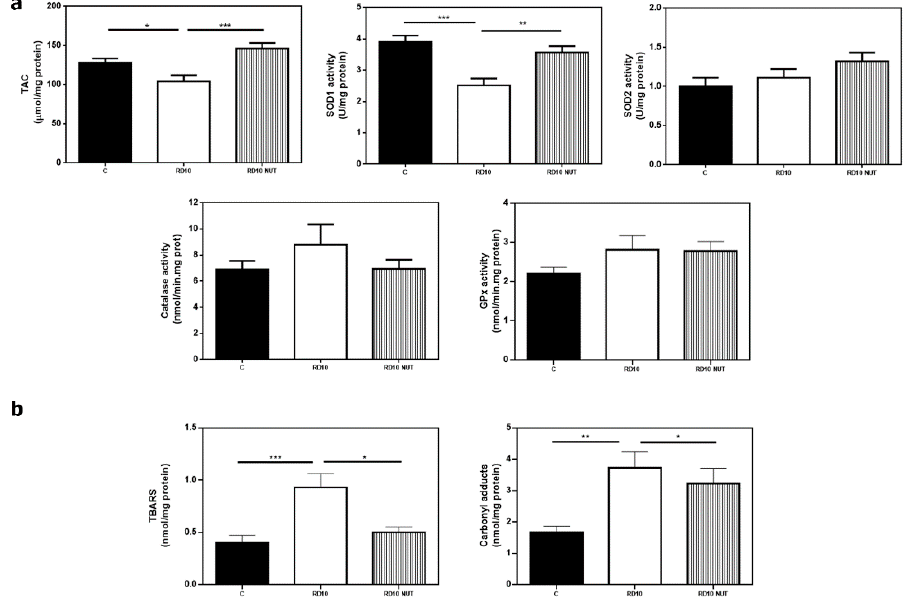
Figure 3. Effect of oral administration of nutraceuticals on retinal redox status in rd10 mice at PD18. ( a ) Values of the antioxidant markers TAC, and activities of superoxide dismutase (SOD) 1 or cytosolic (SOD1), 2 or mitochondrial (SOD2), catalase (CAT) and glutathione peroxidase (GPx),